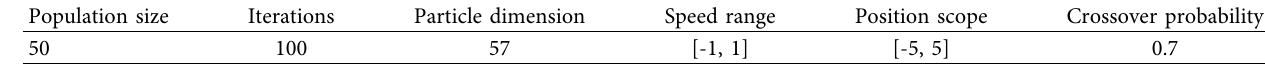
Table 3: Parameter settings of improved HPSO algorithm.